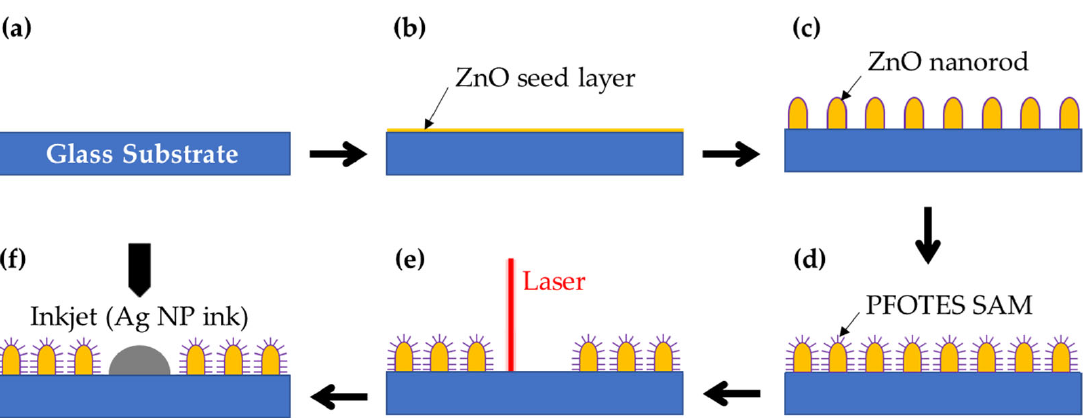
Figure 1. Schematic of the present inkjet process via laser-induced selective surface wetting technique: ( a ) substrate cleaning, ( b ) seed layer coating, ( c ) ZnO nanorod growth, ( d ) formation of PFOTES SAM, ( e ) laser surface treatment, and ( f ) inkjet printing of Ag